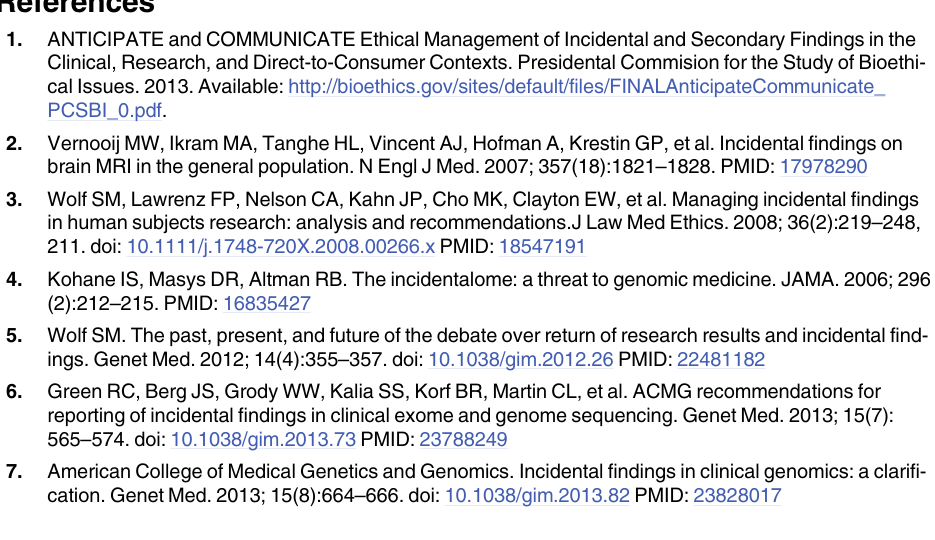
S1 Table. General population prevalence estimates of the ACMG conditions and the devel- opment of frequency thresholds in reference datasets. Population prevalence estimates of the ACMG conditions were taken from several datasets, including GeneReviews and the Genetics Home Reference. Based on the lowest estimated general population disease prevalence and the mode of inheritance, we calculated the maximum estimated pathogenic variants per person for each disease. From this “ pathogenic variants per person ” estimate, we were able to calculate an expected number of pathogenic variants for each disease in the NHLBI Exome Sequencing Project and the 1000 Genomes. Assuming that the occurrence of multiple variants within each reference dataset followed a Poisson distribution, we calculated a threshold number of variants that exceeds the 95 th cumulative probability percentile with an event rate equal to the expected number of pathogenic variants in that dataset. Keeping with our cautious approach, we removed variants associated with each disease that occurred more frequently than this upper bound 95th percentile in each dataset. Details on all filtered variants along with notes and refer- ences of the literature review are available in S2 Table. (cid:3) When the number of expected people exceeding the 95th cumulative probability percentile was small (3 or less), we used a minimum cut off of 4 individuals to prevent the removal of possible population specific variants. S2 Table. Characteristics of 237 Filtered Variants from Literature Review. Candidate vari- ants identified by informatics filtering were examined for disease association through critical appraisal of the literature. Variant frequency in reference datasets was considered with the liter- ature review. This table provides detailed information on all 237 variants, including notes from that literature review and PubMed Identification numbers of all articles